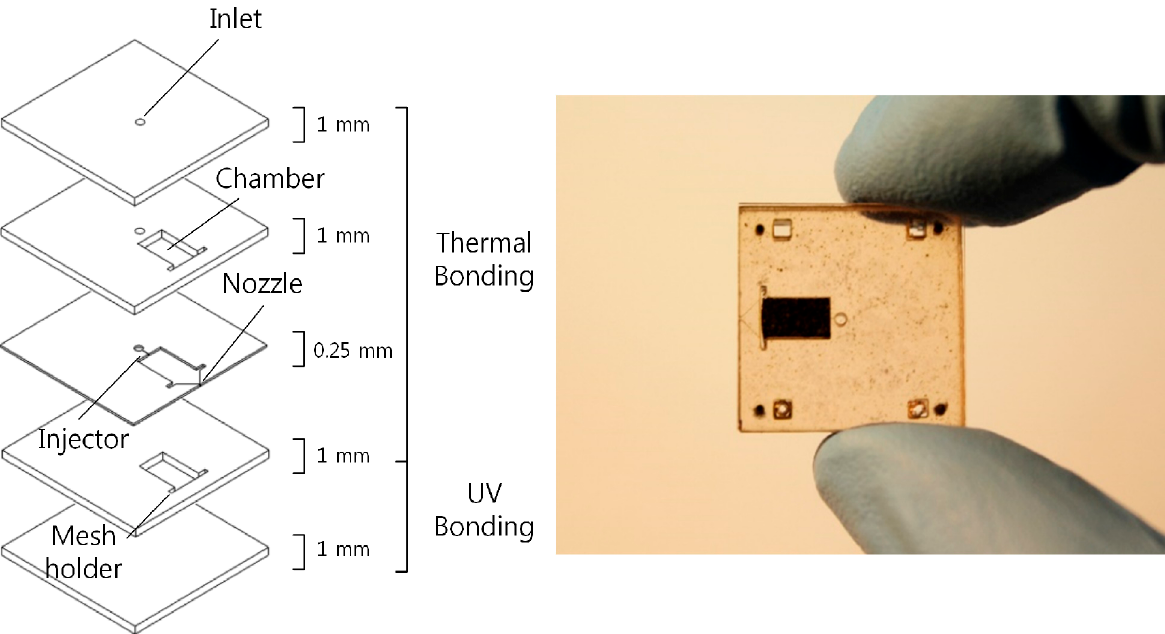
Figure 1. Microthruster design profile [20] considered for numerical comparative performance study.